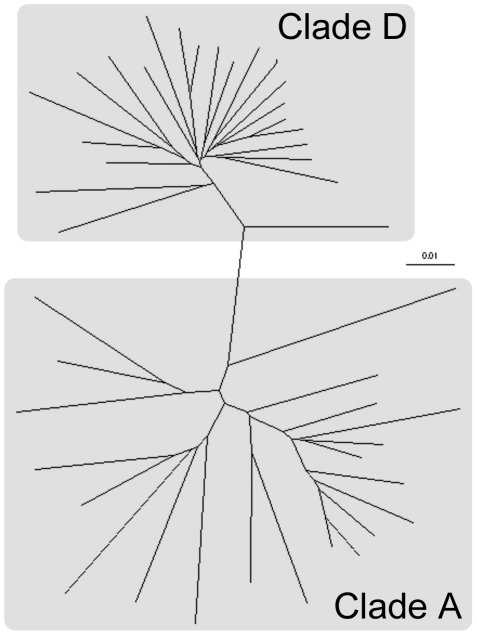
Radial tree showing degree of identity between the study participants' HIV isolates.RT-PCR was undertaken to amplify sequence from the reverse transcripase gene that was subsequently used to construct the tree. The branch lengths and scale correspond to the number of substitutions/mutations per site.